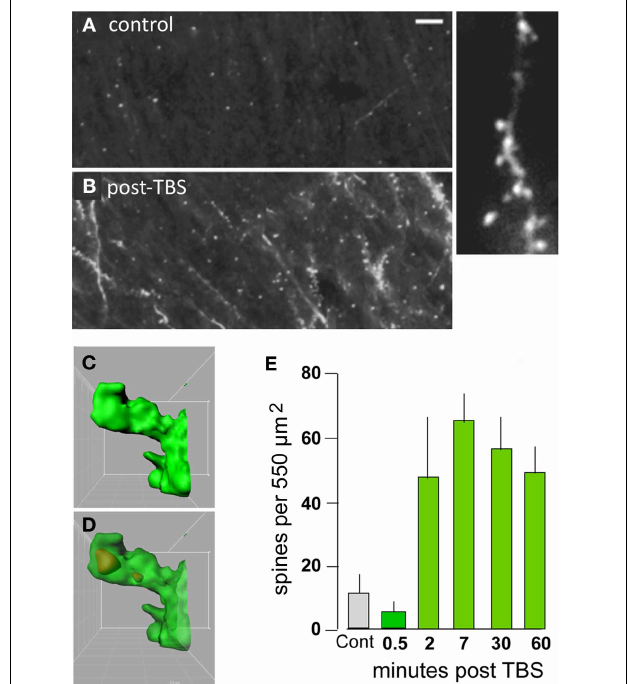
FIGURE 3 | Theta burst afferent stimulation (TBS) causes actin polymerization in dendritic spines. Fluorescent-taggedphalloidin was infused into living hippocampal slices to label filamentous (F) actin; after harvest the slices were sectioned for epifluorescence microscopy. (A,B) Images at left show that spine-labeling (white puncta) is very low in a control slice but prominent following TBS. At higher magnification (at right) labeled puncta can be seen to be spines decorating a faintly labeled dendrite. (C,D) Combining phalloidin labeling with green fluorescent protein expression allows confocal visualization of phalloidin-labeled puncta within the heads of clearly defined spines; panels show opaque 3D build of a single spine (C) and a semi-transparent rendering showing the phalloidin-labeled aggregate within the spine’s boundaries (D) . (E) Quantification of densely phalloidin-labeled spines at different time points following TBS shows that numbers are significantly increased, relative to values in control (cont.) slices, as early as 2min post-TBS and remain elevated through 60min after stimulation ( p > 0 . 001 for 2–60min vs. cont). Modified from Kramar et al. (2012b).